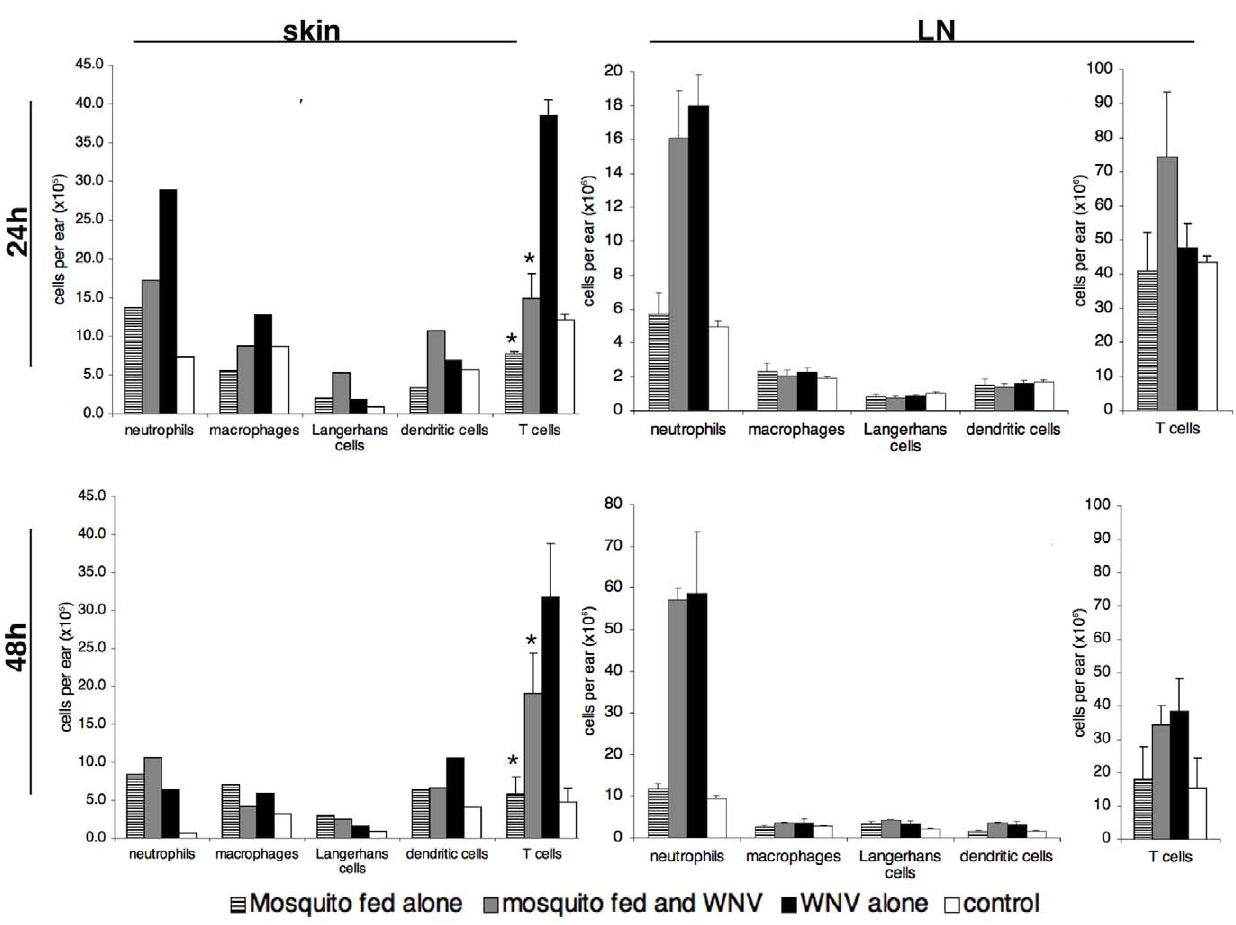
Figure 4. Leukocytes present in the dermal site of inoculation and the draining lymph nodes at 24 and 48 h after intradermal inoculation of WNV. Mice were inoculated with 10 4 pfu of WNV in 10 m l of PBS with (n=5) or without (n=5) mosquito exposure, exposed to mosquitoes in the absence of WNV (n=5), or mock infected with PBS alone (n=3). Cells obtained from three ears per group were pooled, while lymph nodes were assessed individually. The populations of leukocytes were identified by staining and flow cytometry as described in Materials and Methods. The data shown for lymph nodes are the mean 6 standard deviation (representative of 3 experimental replicates). The data for the skin are displayed as the cell numbers from the pooled samples, and the differences between experimental groups are representative of three independent replicates of this experiment. The skin T cells are represented as the mean 6 standard deviation of three separate experiments; analysis of the other skin populations in this manner (across replicates) was not possible due to relatively large, yet proportional, differences that existed between replicates. Nonetheless, the differences between groups maintained a similar pattern in individual experiments, regardless of the variation in levels of particular cell types. An asterisk indicates values significantly different (p , 0.05) than the values in the comparable cell populations of the group exposed to WNV alone as determined by Mann-Whitney test.